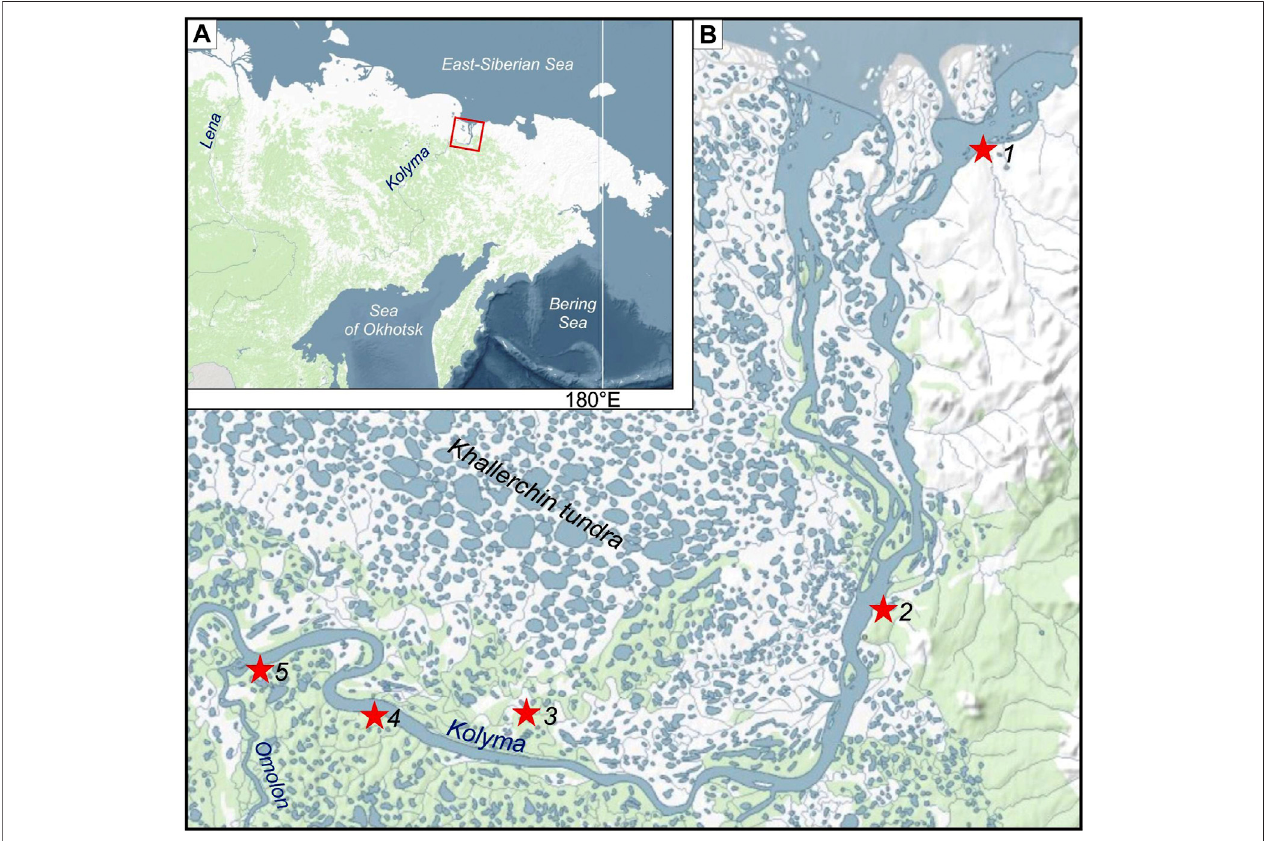
FIGURE 1 | Study area (A) and location of the sampling sites at the Kolyma Lowland (B) . Sites are numbered: 1 (cid:2) Kur ’ ishka; 2 (cid:2) Zelyony Mys; 3 (cid:2) Plakhinskii Yar; 4 (cid:2) Duvanny Yar; 5 (cid:2) Kolymskoe.